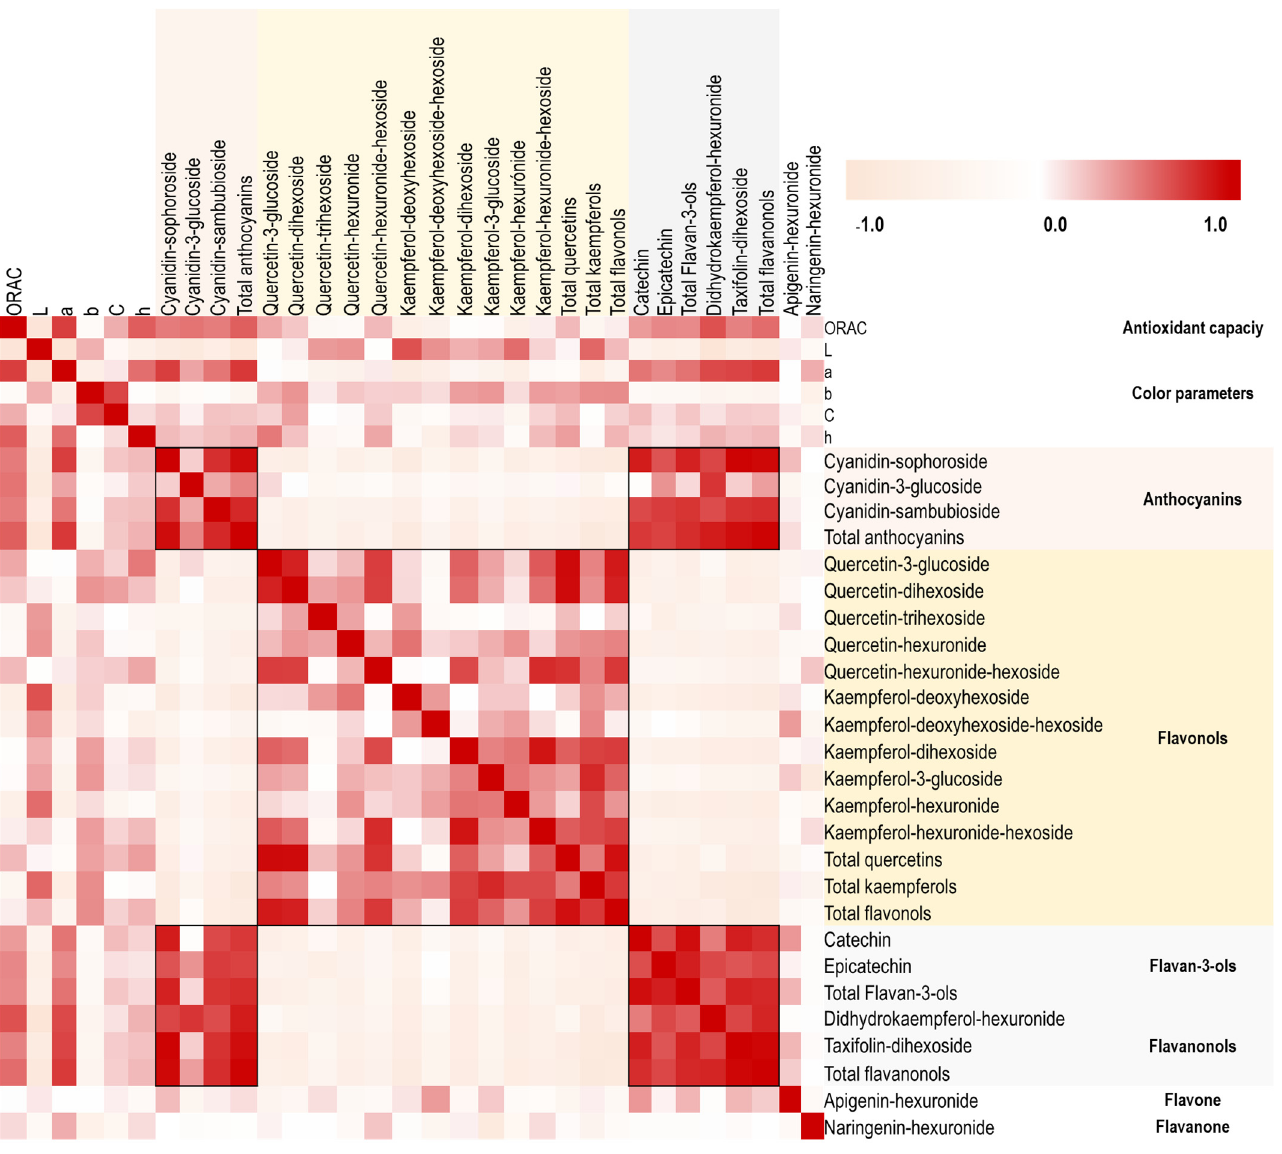
Figure 5. Heatmap of the correlation matrix of the color parameters, antioxidant capacity (ORAC) and 20 compounds present in the extracts of the 16 cultivars of H. rosa ‐ sinensis . Each square indicates the Pearson correlation coefficient for a data pair, and the intensity of the red and beige colors in the heatmap indicates the level of positive and negative correlation, respectively.